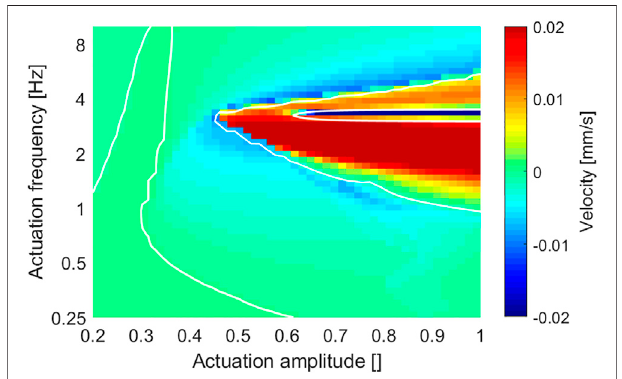
FIGURE 6 | Overview of the robot locomotion velocity under different actuation amplitudes and frequencies. 1) Overall velocity range is suppressed to show more low-velocity details; and 2) white contour line shows the zero- velocity separation.